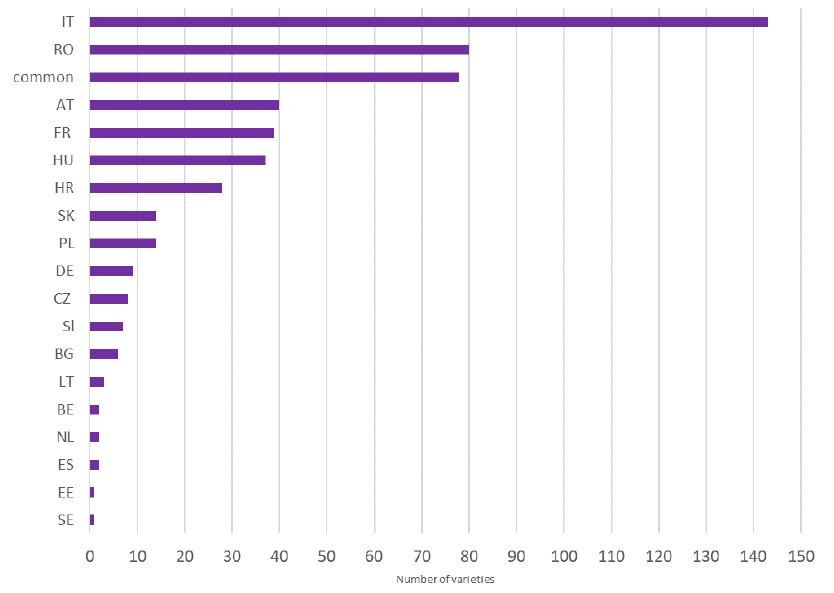
Figure 23. Number of soybean varieties in EU countries [44].